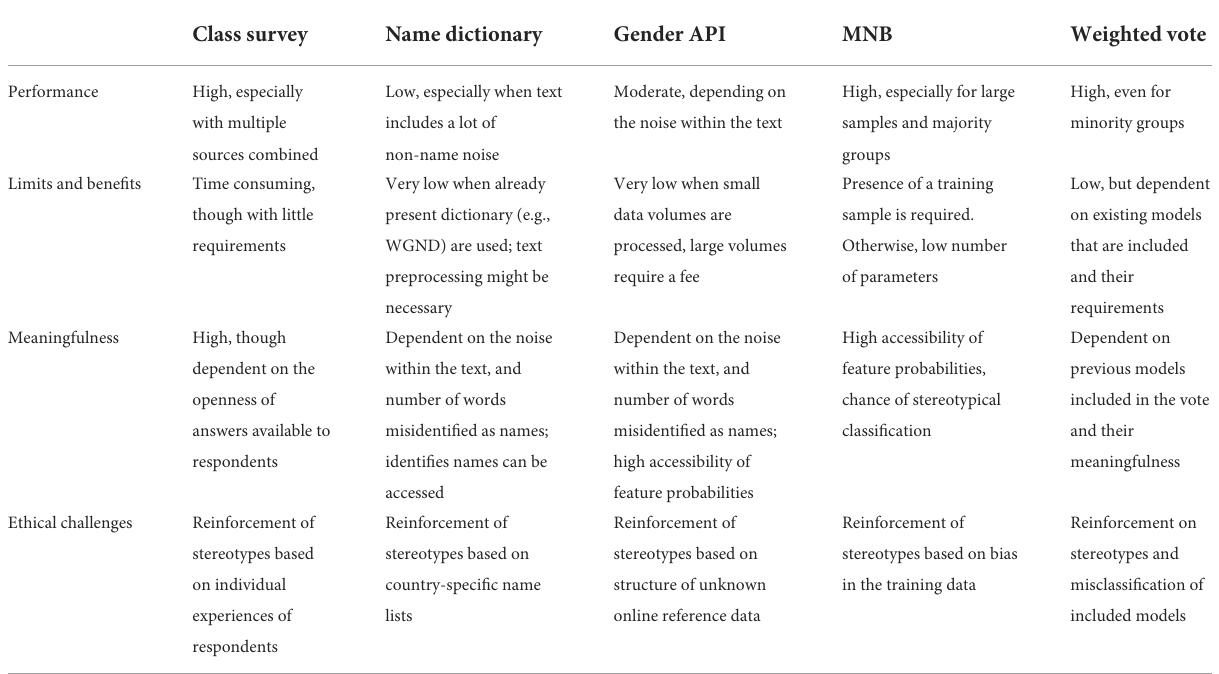
TABLE 4 Overview of the